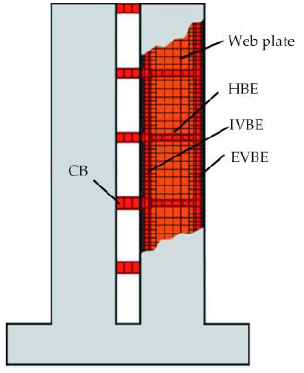
Figure 1. Concept of C-SPRC composite wall.